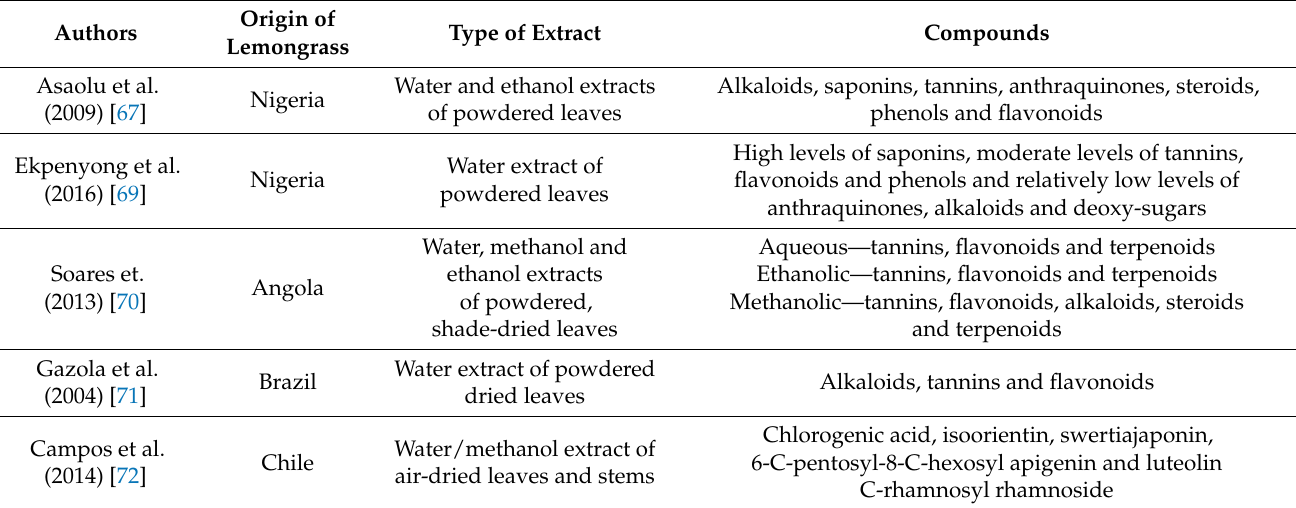
Table 2. Classes of polyphenol compounds identified in the lemongrass